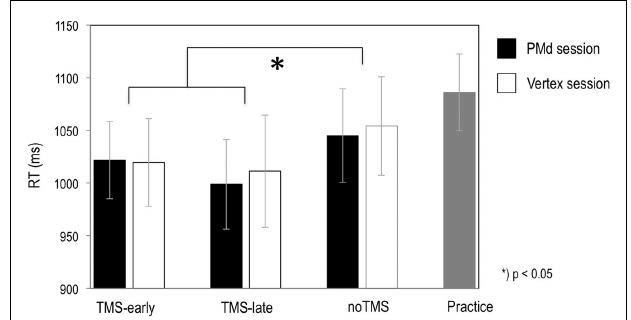
FIGURE 3 | Graphs show the mean RTs forTMS-early andTMS-late in the left PMd and in theVX for trials with coherently timed action continuations after occlusion. RTs from noTMS trials (i.e., trials without TMS that were randomly intermixed betweenTMS trials in each session) and from the practice session were considered as measures of baseline performance. Bars represent SE.